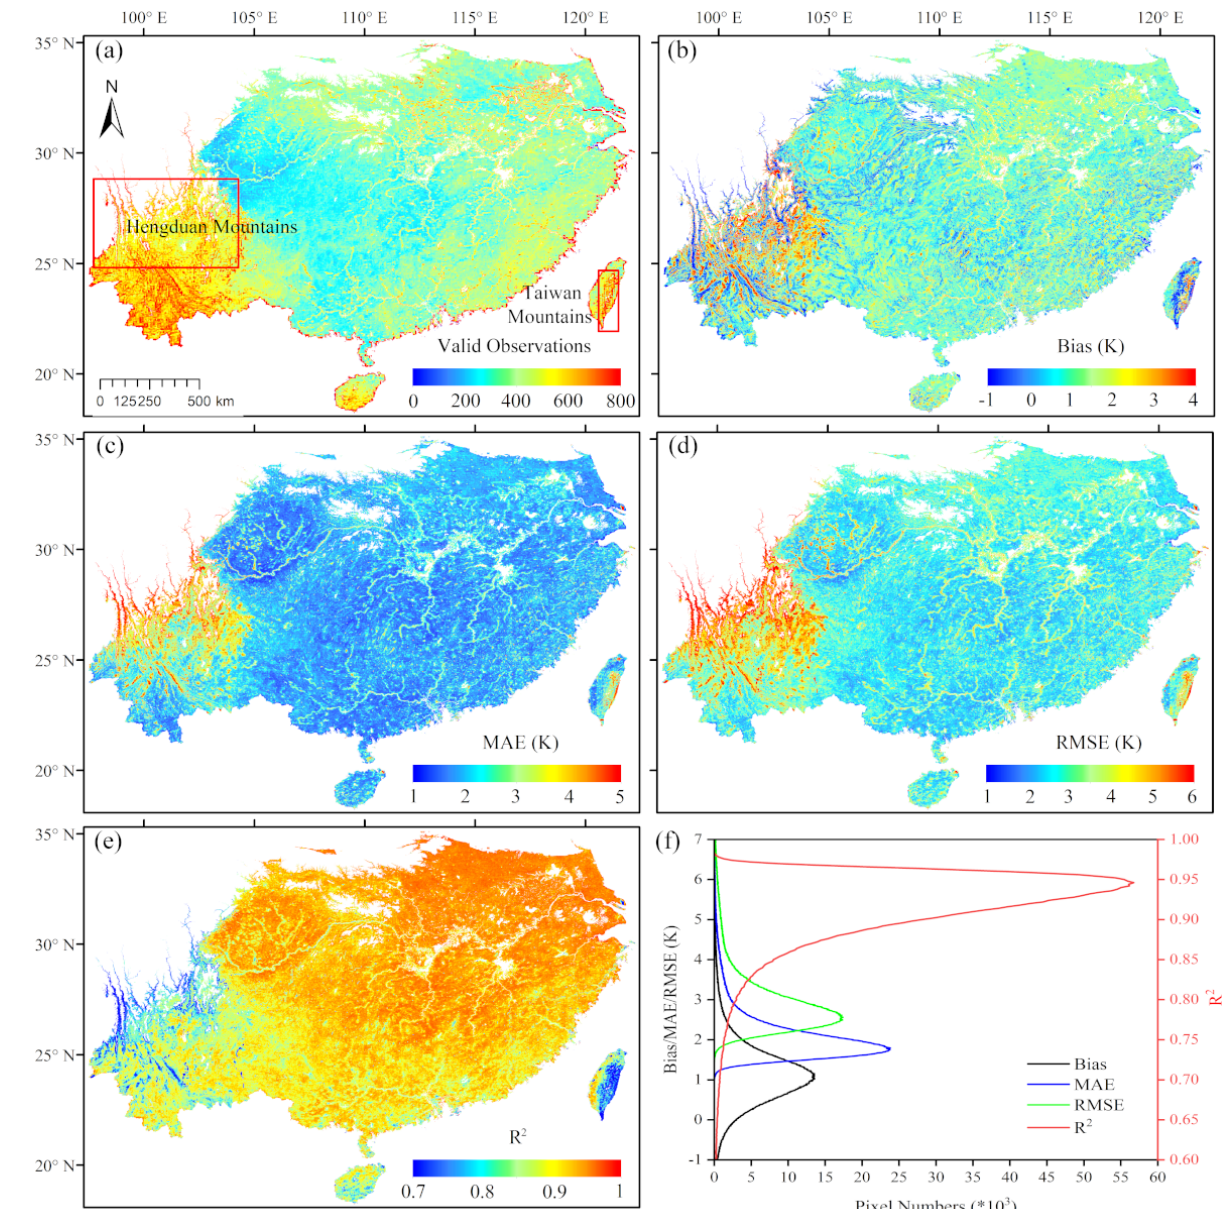
Figure 3. Spatial patterns and frequency distribution curves of statistical metrics between the MLP-GTWR LST (1 km) and MODIS LST (1 km) for the pixels without being used in aggregation to the 10-km MODIS LST. ( a ) The spatial pattern of the valid observations (Days) of MODIS LST (1 km) without being used in aggregation to the 10-km MODIS LST. The higher pixel number in the narrow zone of the seashore is because the pixels have a large part of water surface and are not used in aggregation to the coarse-resolution LST. ( b – e ) The spatial patterns of the bias, MAE, RMSE, and R 2 . ( f ) The frequency distribution curves of above four statistical